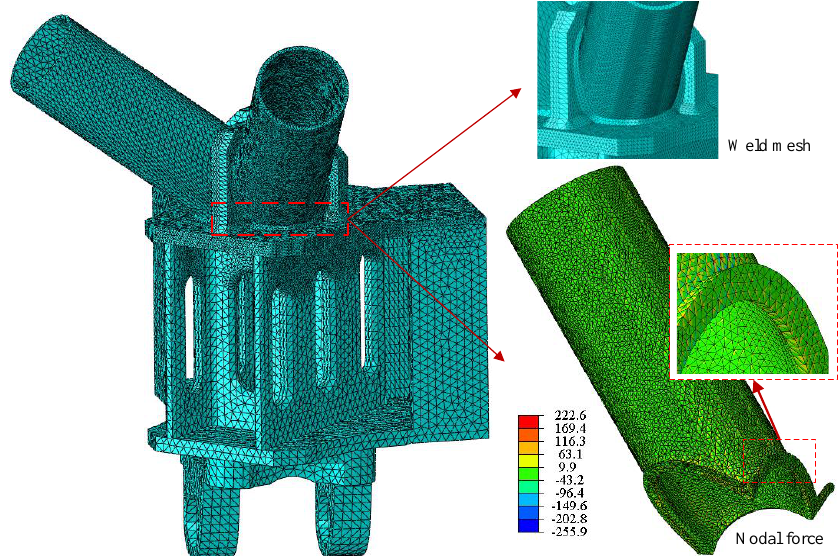
Figure 18. FEM and nodal force of the longitudinal bearing rod welded joint.